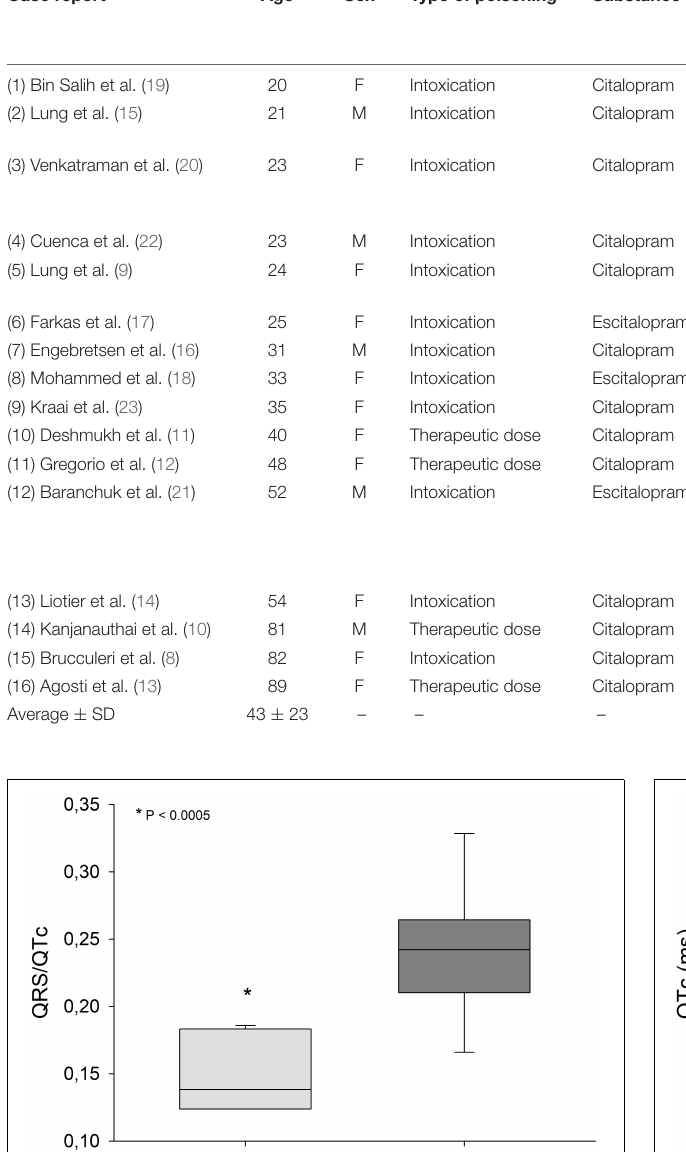
TABLE 1 | Clinical data from the included patients, as given in the case-reports. Case report